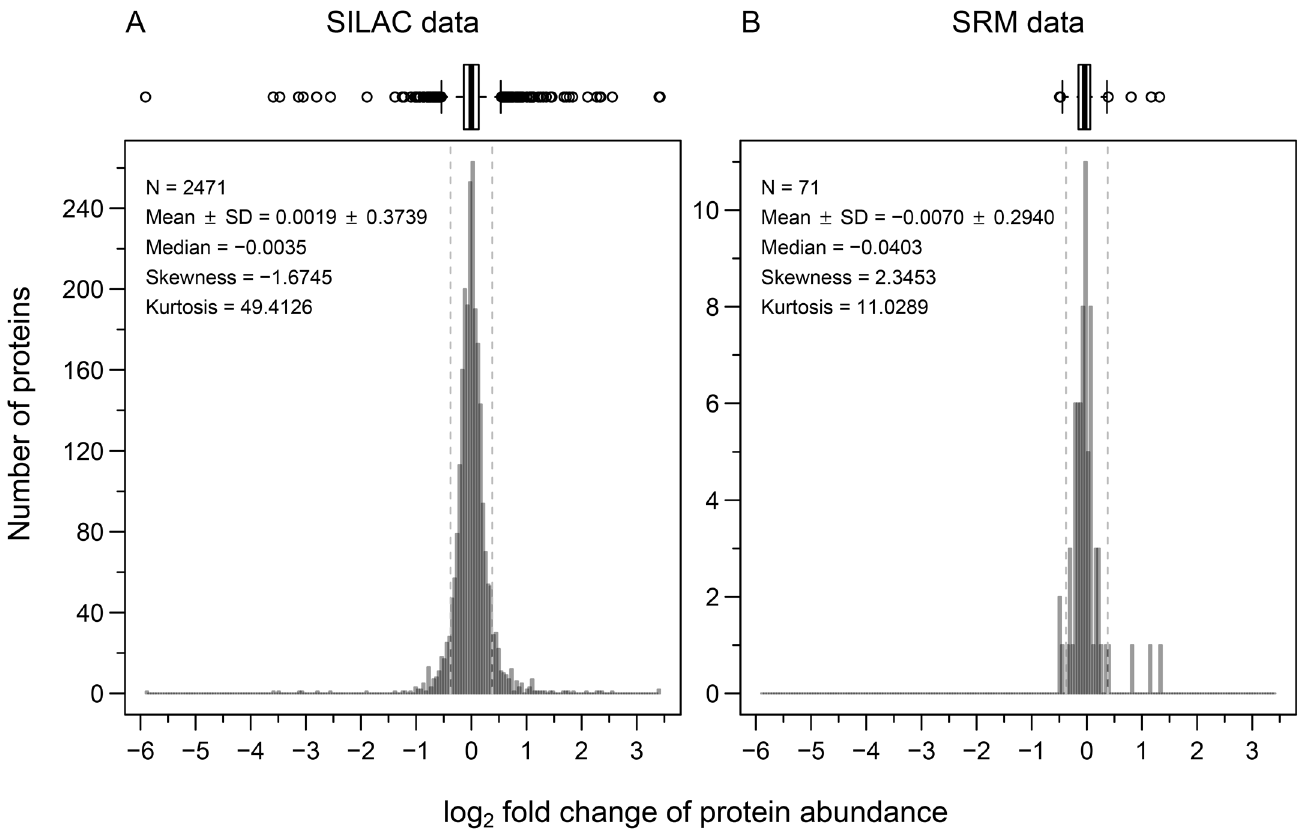
Fig 1. Signalling pathway proteins show a similar variation in abundance between N2 and CB4856 as a C . elegans shotgun proteome dataset. Histogram with Tukey-style box plot [36] on the top for protein abundances measured in CB4856 relative to N2. Vertical dashed lines represent the fold change cut-off of 1.3 (~ 0.38 on log 2 scale). (A) The C . elegans shotgun proteome dataset was quantified using SILAC (data from [35]). (B) Signalling pathway proteins were quantified using SRM.